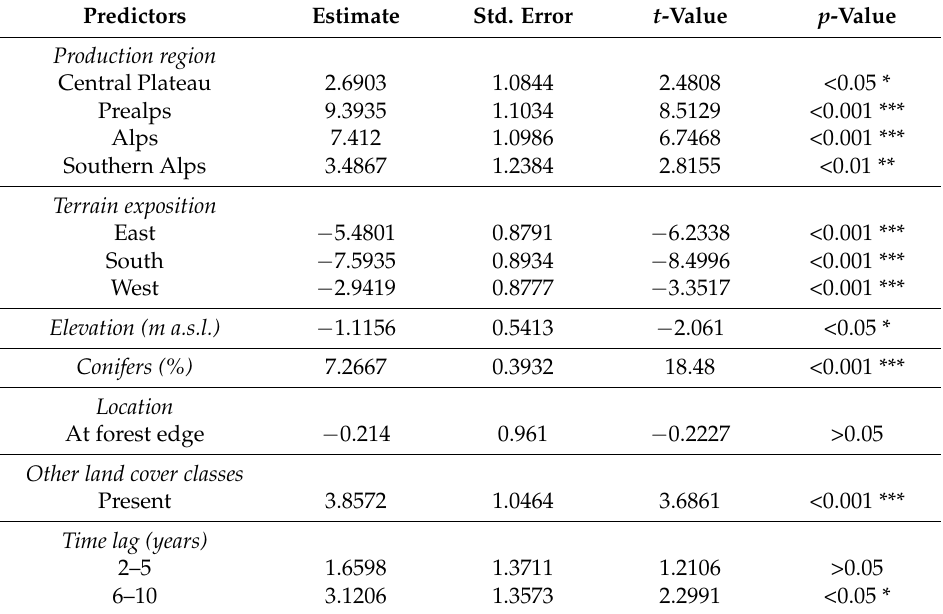
Table 6. Output of a model testing the influence of different parameters on the tree type map validation using multiple linear regression. The multiple linear regression was based on the IAs with at least nine points interpreted as trees and resulted in an adjusted R-squared of 0.18. For the categorical predictors, the following reference categories were chosen: production region—Jura, terrain